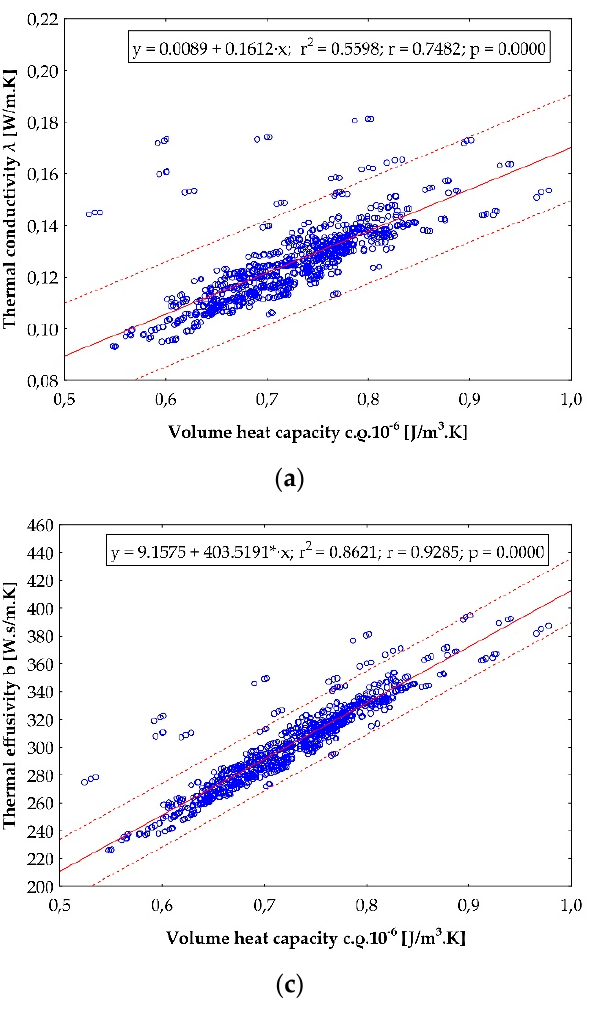
Figure 12. The relationship between ( a ) volume heat capacity and thermal conductivity, ( b ) volume heat capacity and thermal diffusivity, ( c ) volume heat capacity and thermal effusivity, and ( d ) thermal conductivity and thermal effusivity, are shown regardless of heat-treatment degree. Significance level is at a 95%.